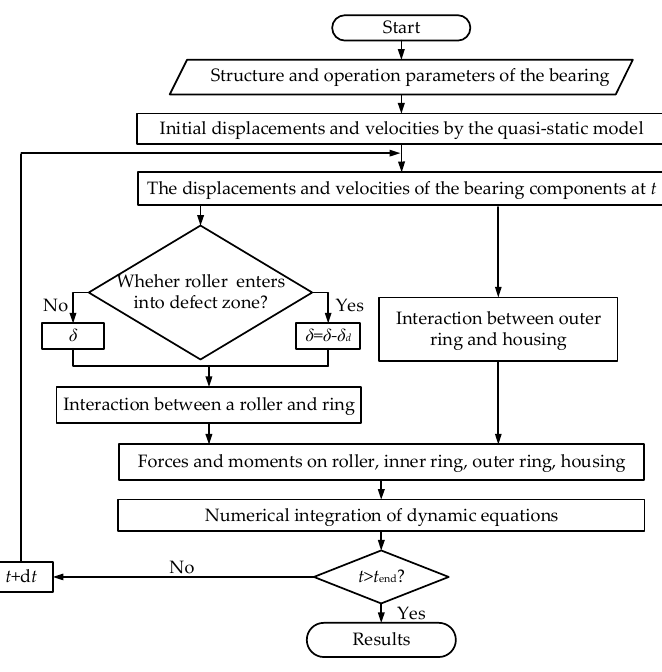
Figure 4. The flow chart for the whole process.